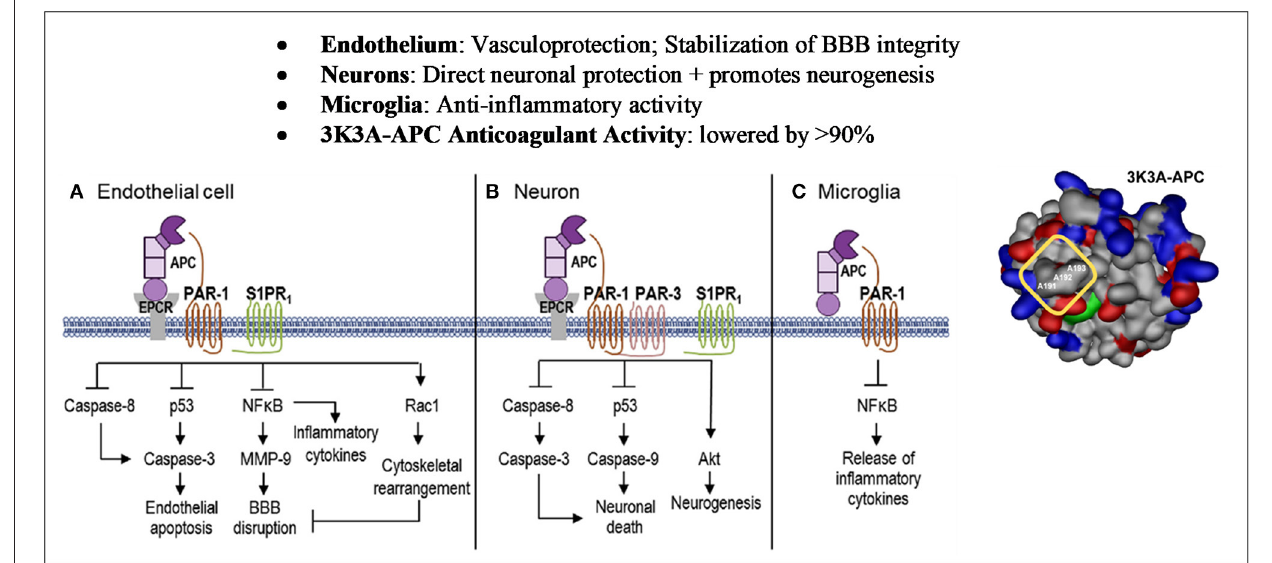
FIGURE 2 | Cell-Specific APC protective signaling pathways. Akt, protein kinase B; APC, activated protein C; BBB, blood–brain barrier; EPCR, endothelial protein C receptor; MMP, matrix metallopeptidase; NFkB, nuclear factor kappa-light-chain-enhancer of activated B cells; PAR, protease-activated receptor; Rac1, Ras-related C3 botulinum toxin substrate 1; S1PR1, sphingosine 1-phosphate receptor 1. Reprinted from neuropharmacology, vol. 134, Amar et al. (69) can adjunctive therapies augment the efficacy of endovascular thrombolysis? A potential role for activated protein C, 293–301, 2018, with permission from Elsevier. 3D structure reprinted from blood, vol. 132(2), Griffin et al. (67) activated protein C, protease activated receptor 1 and neuroprotection; 159–169, 2018, with permission from the American Society of Hematology. (A) In endothelial cells, APC helps to seal the BBB and is vasculoprotective. APC/EPCR activates PAR-1 and inhibits caspase-8 activation